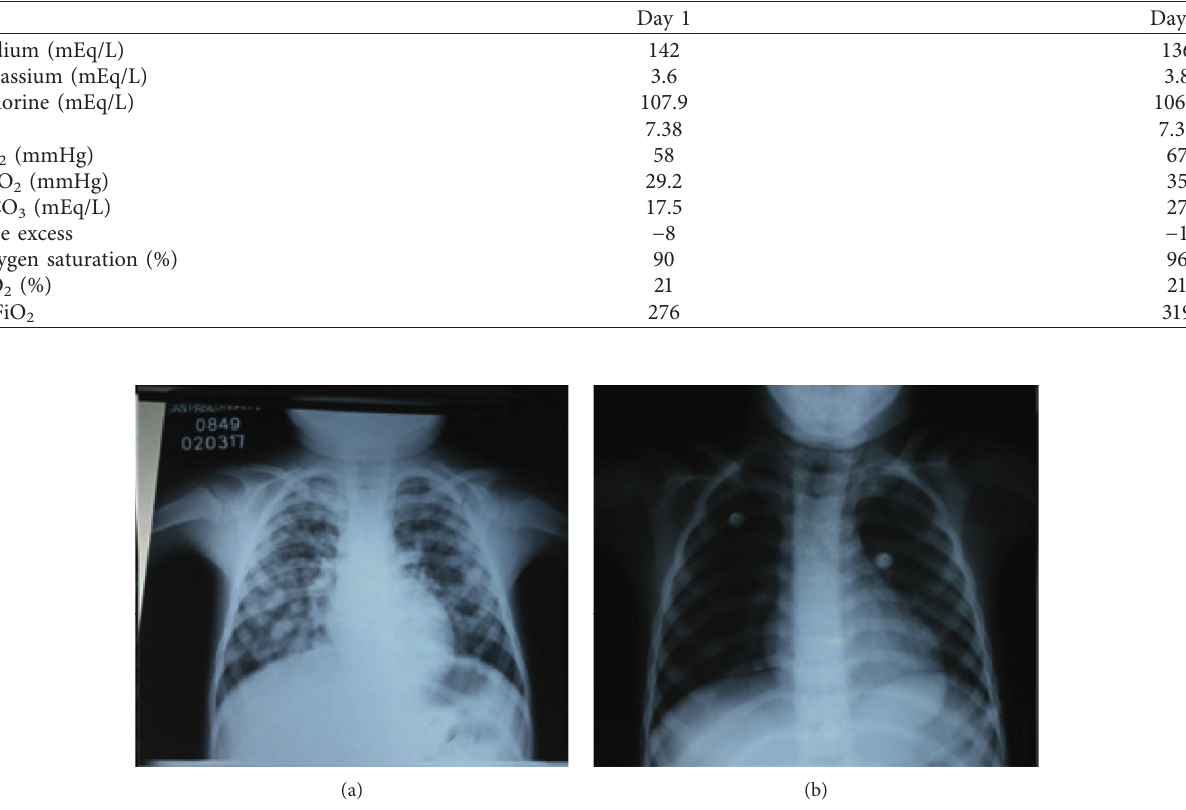
Figure 1: X-ray upon admission to the emergency unit (a) and prior to discharge of the same case (b).